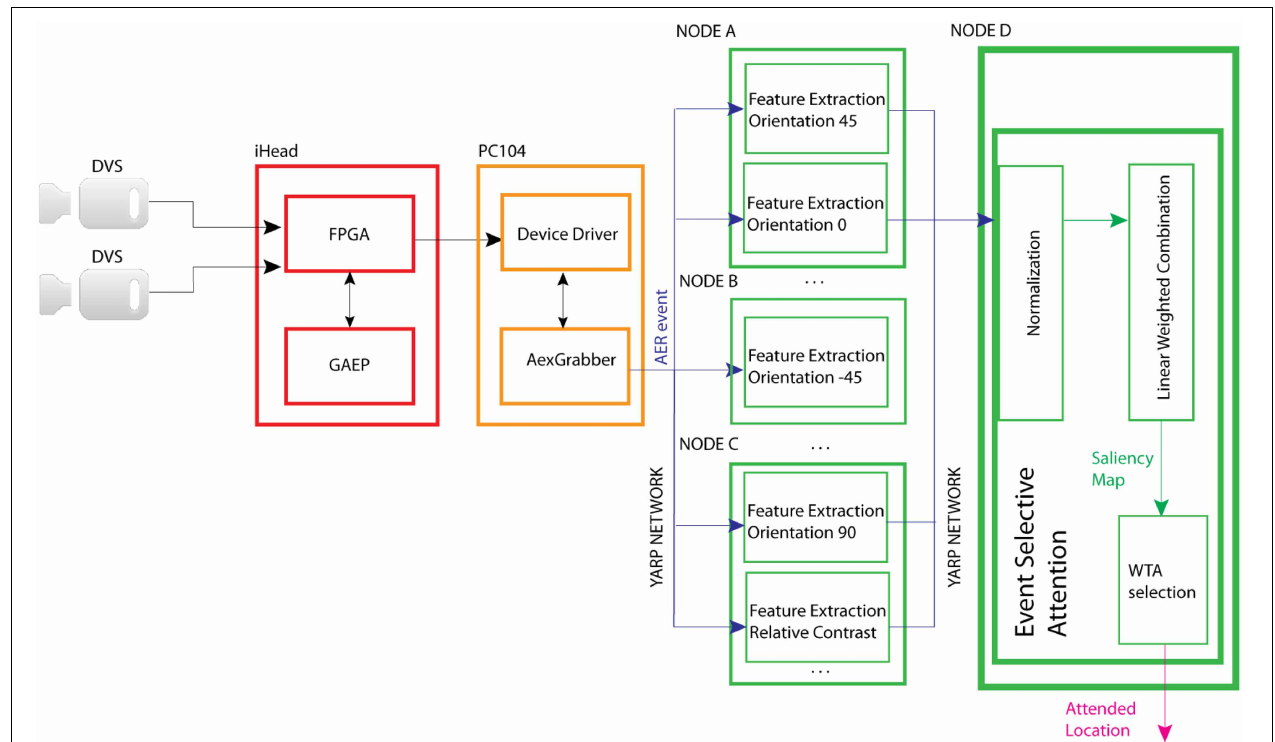
FIGURE 1 | Structure of EVA and its implementation on the diverse HW modules: the DVS cameras send asynchronous events, the FPGA merges left and right DVS events, the GAEP assigns a timestamp to each event. The resulting list of addresses and timestamps is sent to the PC104 that makes them available to the YARP network through the